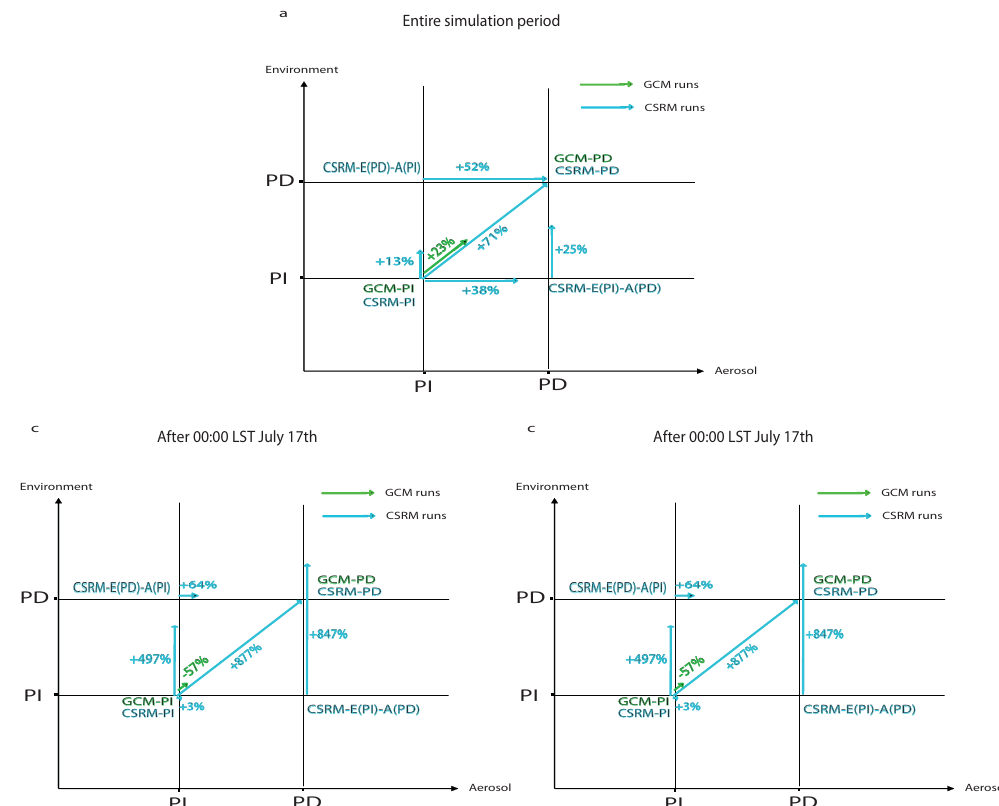
Fig. 8. Schematic diagrams illustrating the percentage change in LWP due to changes in the environment and aerosols. (a) , (b) , and (c) are for the entire simulation period and the period before and after 00:00LST on 17 July, respectively. The abscissa and the ordinate represent the environment and the aerosol conditions, respectively, and PI and PD represent the preindustrial and present-day conditions, respectively. Each of arrows represents the magnitude of the percentage changes (proportional to an arrow length) in LWP and the direction of changes in conditions (indicated by an arrowhead). The green and blue arrows represent these changes in the GCM and the CSRM simulations, respectively. The arrow length is scaled relative to the longest arrow (the diagonal blue arrow for (a) and (c) and the diagonal green arrow for (b)) in each figure. The two horizontal (vertical) arrows are for changes in LWP due to changes in aerosols (the environment) from the PI condition to the PD condition at either the PI environment (aerosol), represented by the lower (left) arrow, or the PD environment (aerosol), represented by the upper (right) arrow. The diagonal arrow is for the LWP change due to simultaneous changes in aerosol and environment from the PI conditions to the PD conditions. For reference, the value of the percentage variation of LWP is shown near a corresponding arrow. The plus and minus in the value indicate an increase and a decrease in LWP, respectively. The names of experiments from which LWP values are produced to calculate a LWP change are shown around the starting point and in front of an arrowhead of a corresponding